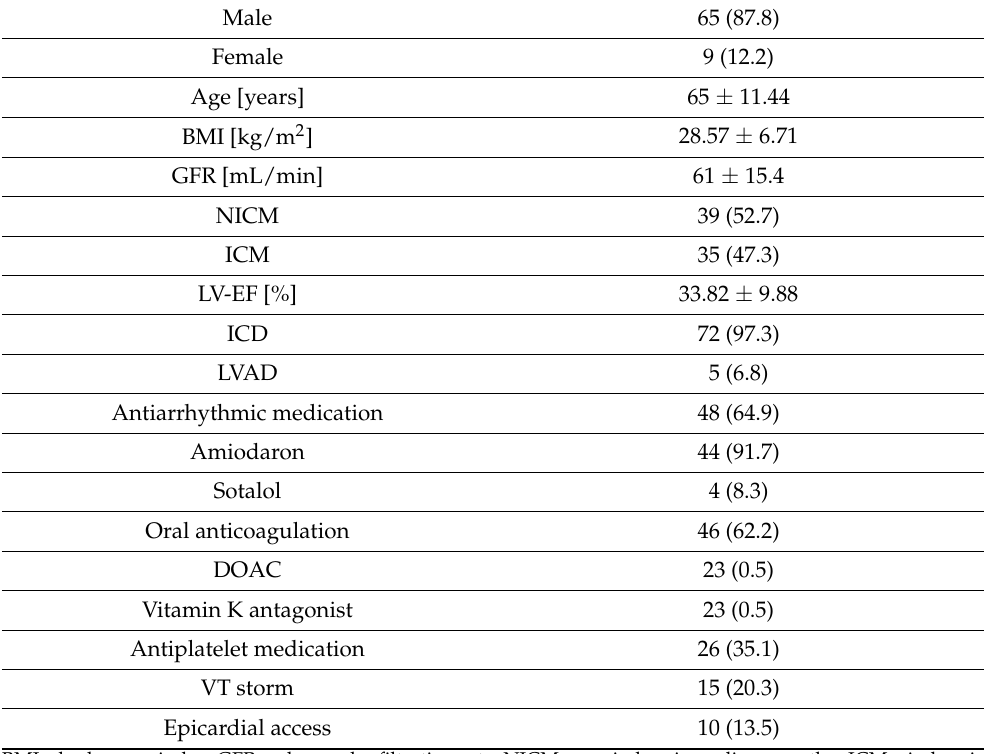
Table 1. Baseline